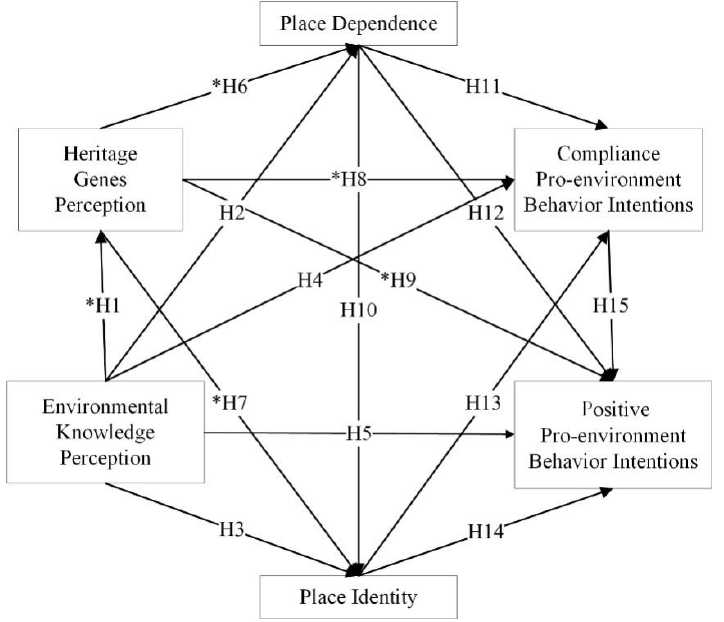
Figure 1. EHPP conceptual model. Note: * indicates hypotheses empirically tested for the first time using the structural equation model.